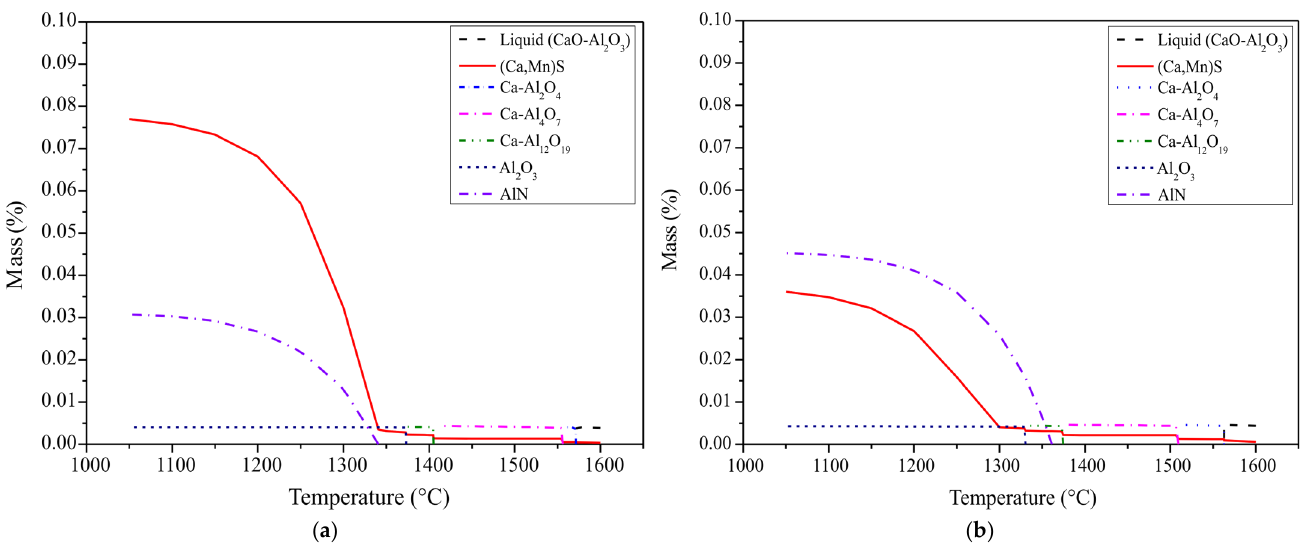
Figure 6. Equilibrium precipitation of inclusions and evolution during steel solidification. ( a ) GS1 sample, ( b ) GS2 sample.